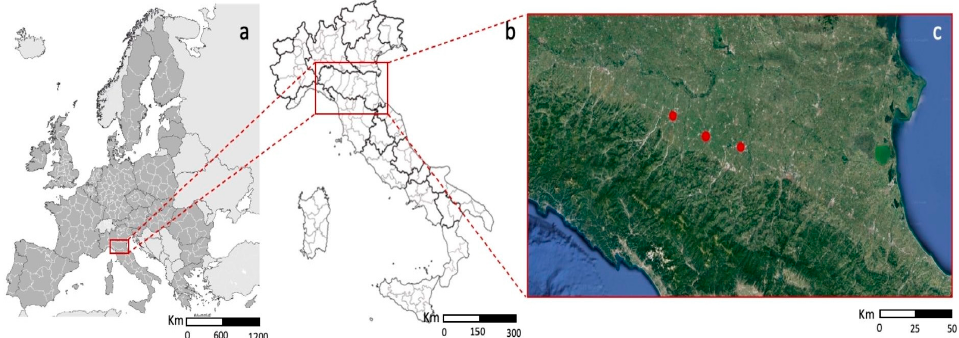
Figure 1. Case study area. ( a ) EU Region (NUTS2) Emilia-romagna region. ( b ) IT Province (NUTS3). From the left, Parma, Reggio Emilia and Modena provinces. ( c ) Pianura Padana Context. From the left Parma, Reggio Emilia and Modena cities.